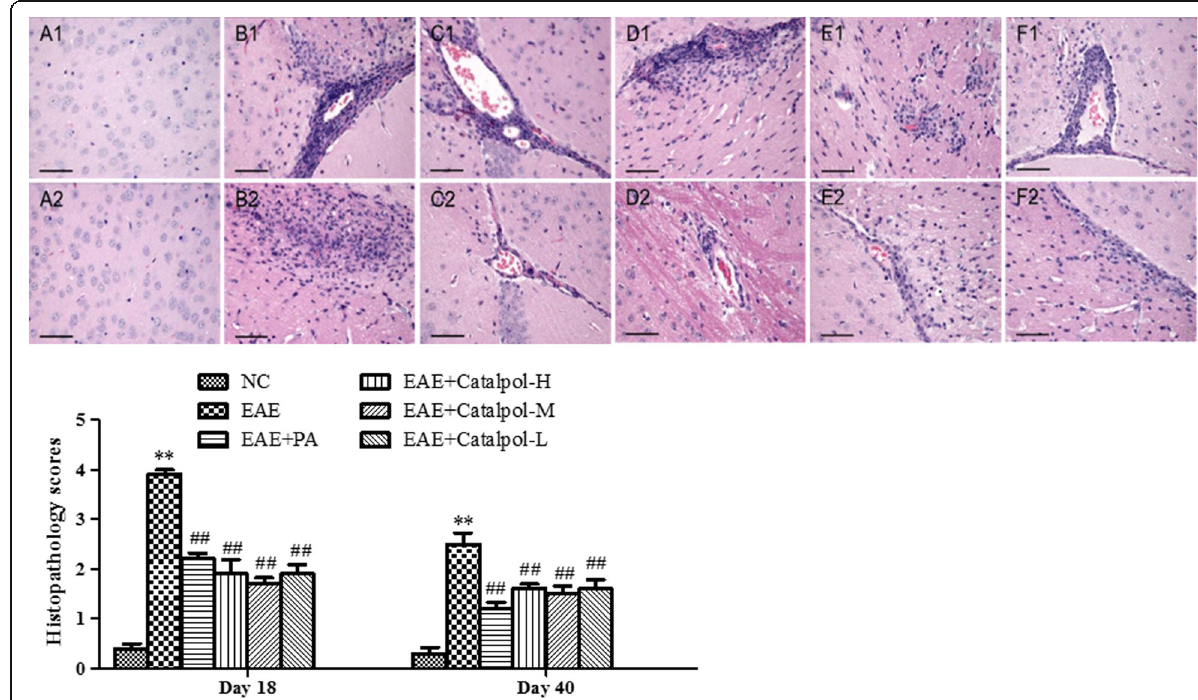
Fig. 2 Observation of pathological changes in the brains of mice under the light microscope with H&E staining. A1 to F1 and A2 to F2 show the pathological changes in the brains of mice on Day 18 and Day 40 in NC ( n = 4), EAE ( n = 4), EAE+ PA ( n = 4), EAE + Catalpol – H ( n = 4), M ( n = 4) and L ( n = 4) mice, respectively (scale bar 20 μ m). Note: ** P < 0.01 vs. NC; ## P < 0.01 vs. EAE